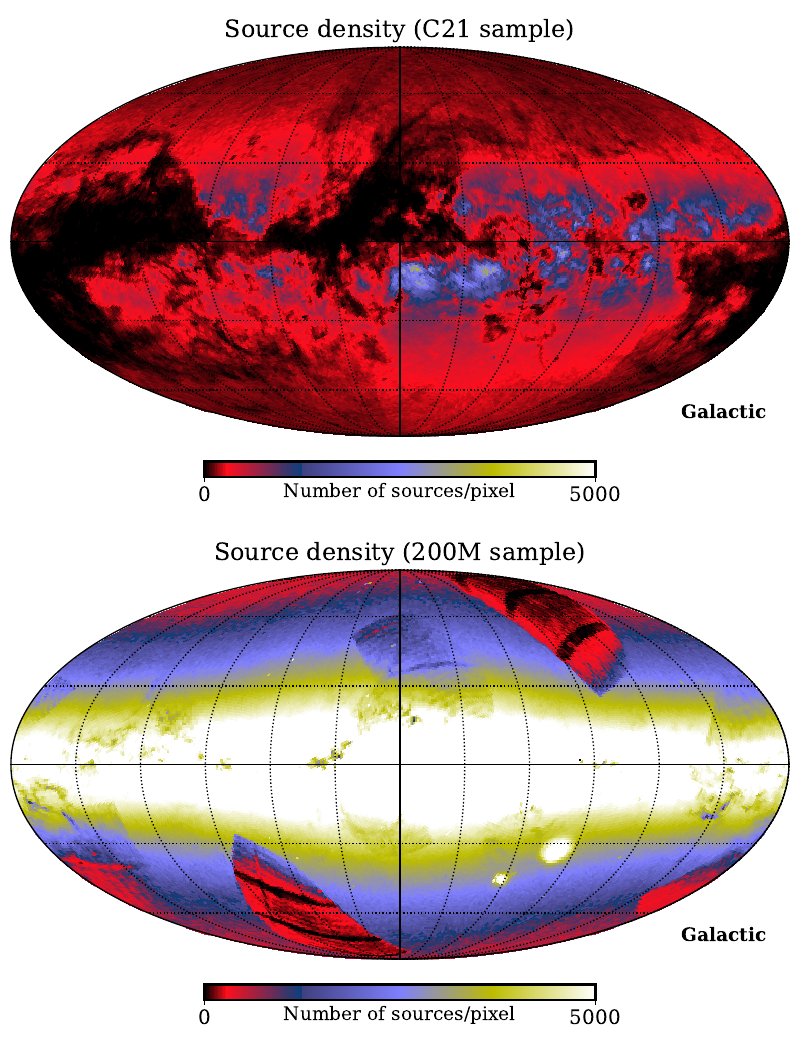
Figure 4. Source density maps, in Galactic coordinates, corresponding to the C21 ( top ) and the 200 M ( bottom ) samples. These maps were created using HEALPIX of level 6 (providing a pixel size of 0.84 square degrees) and are colour coded depending on the number of sources within the pixel. Note that the colour scale is the same in both maps. See Figure 5 for a histogram comparison of the source density in these